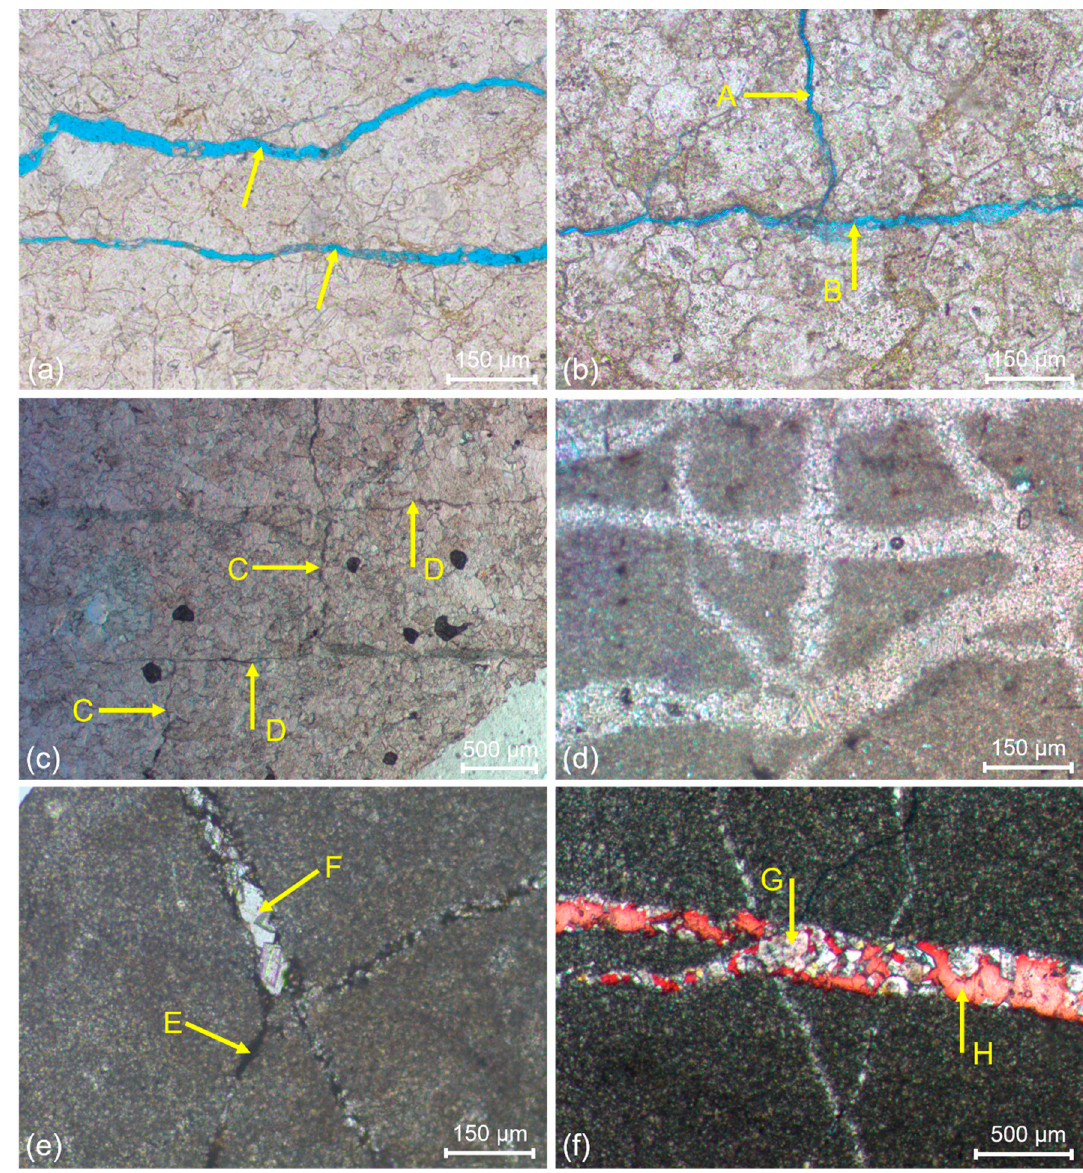
Figure 8. Tectonic fractures in thin sections. ( a ) Fractures in Well R2, depth 5039.60 m (16,534.12 ft). ( b ) Fractures in Well R2, depth 5039.35 m (16,533.30 ft). Group B terminated Group A. ( c ) Fractures in Well R5, depth 5916.02 m (19,409.51 ft). Group D terminated Group C. ( d ) Fractures are filled with calcite in Well R9, depth 4548.10 m (14,921.59 ft). ( e ) Fractures in Well R5, depth 5728.31 m (18,793.67